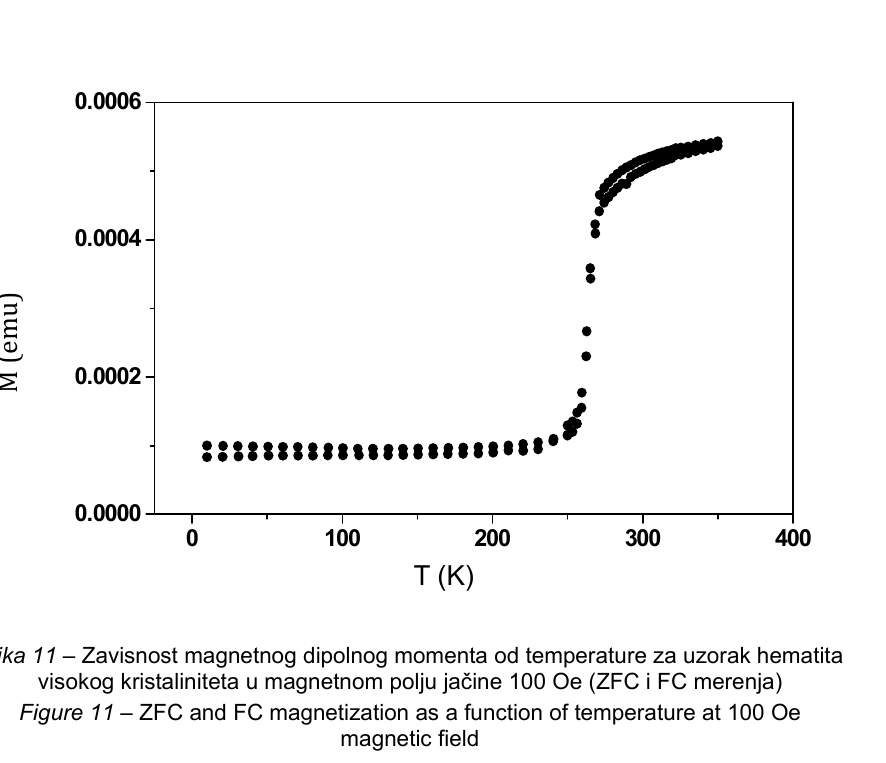
Figure 11 – ZFC and FC magnetization as a function of temperature at 100 Oe magnetic field